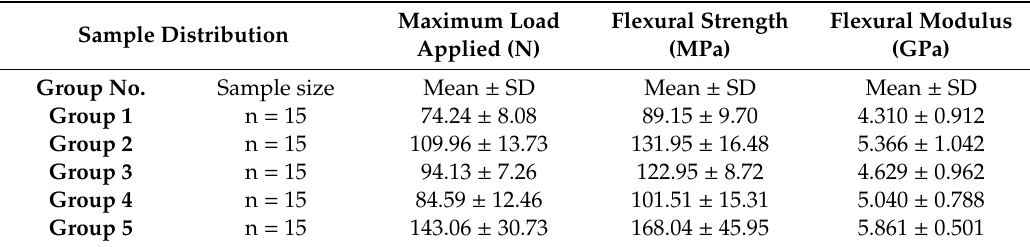
Table 2. Distributions of mean ± standard deviation (SD) maximum load, mean flexural strength, and mean flexural modulus across five study groups.